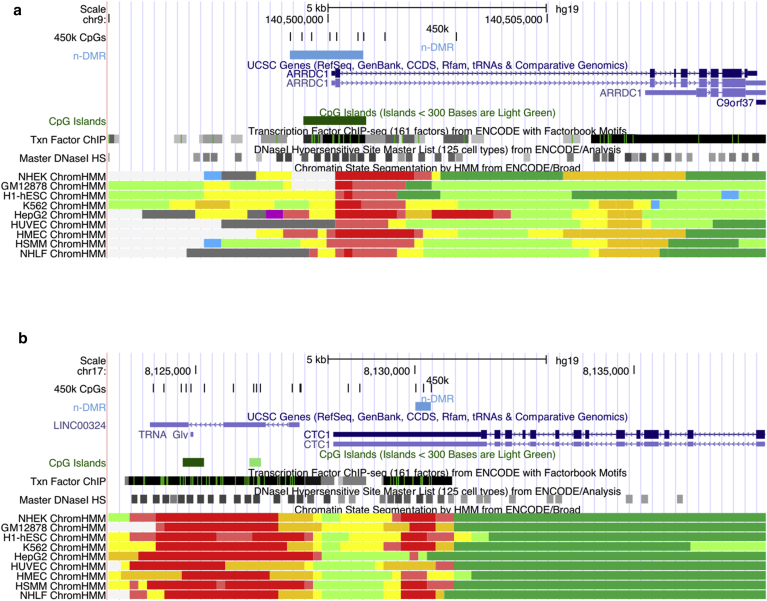
Location of two top-ranked n-DMRs in the human genome. Figures obtained from UCSC Genome browser, displaying position in the genome (hg19), CpG sites from HumanMethylation450 BeadChip, n-DMR (in light blue), RefSeq genes, CpG island, transcription factor ChIP data, DNase-I sensitivity sites, and ChromHMM genomic segmentation. (a) At ARRDC1. (b) At CTC1. DMR, differentially methylated region.